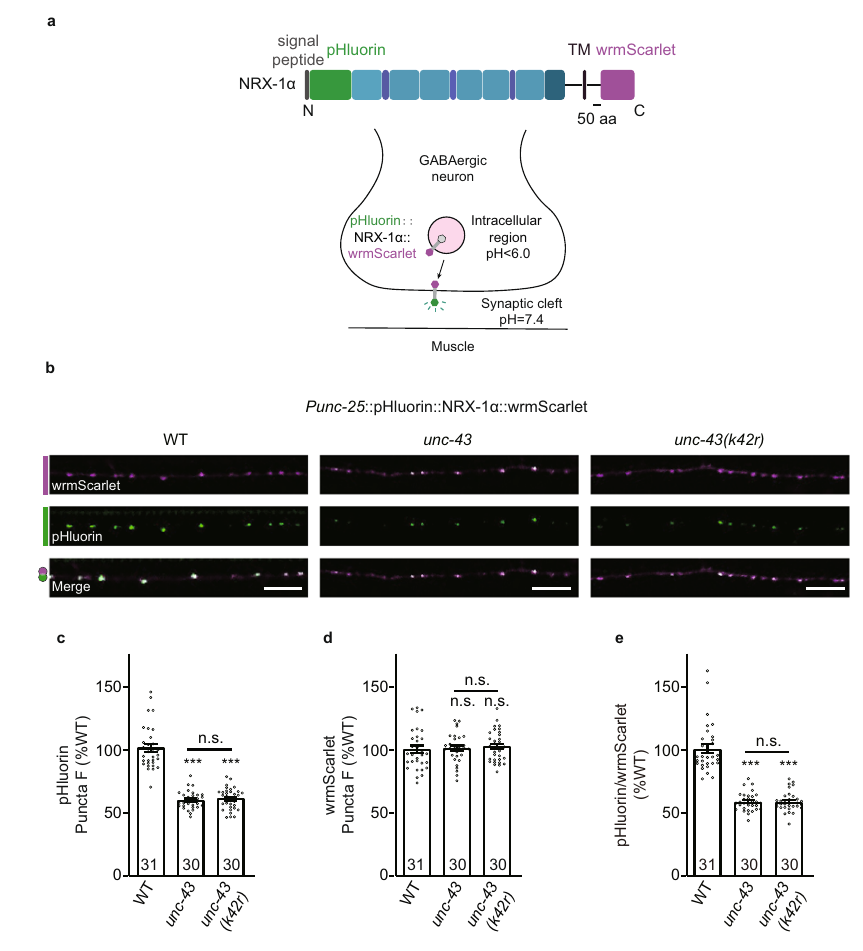
Fig. 7 | UNC-43/CaMKII promotes NRX-1 α /neurexin GABAergic motor neuron surface localization. a Schematic representation of N-terminal pH-sensitive GFP pHluorin-tagged and C-terminal wrmScarlet-tagged NRX-1 α fusion under unc-25 promoter. pHluorin-NRX-1 α are fl uorescent upon insertion in the plasma mem- branetoexposepHluorinintheextracellularenvironment(pH>6). b – e Thesurface localizationofNRX-1 α isdecreasedinthe unc-43 mutants.pHluorinandwrmScarlet dual-labeled NRX-1 α was expressed in GABAergic neurons. pHluorin-NRX-1 α puncta (green) fl uorescence in the dorsal nerve cords was decreased in the unc-43